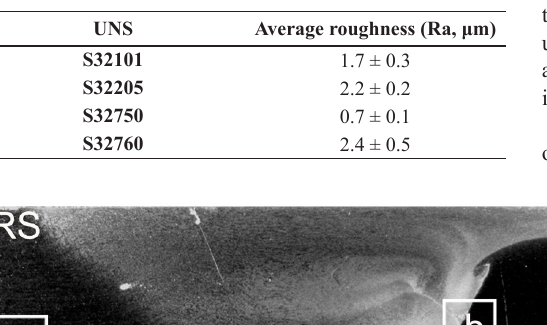
Table 3. Average roughness values for the FSW